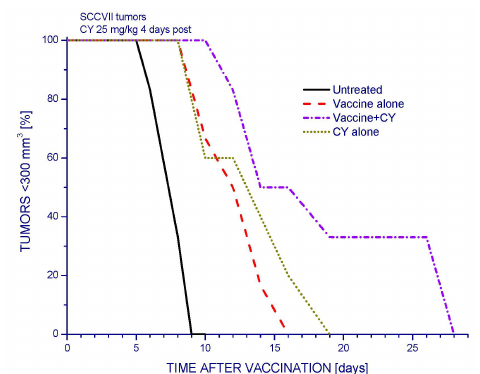
Figure 2. Increased efficacy of PDT vaccine when combined with cyclophosphamide treatment. Mice with SCCVII tumors were treated with PDT vaccine as described for Figure 1. Single injection of cyclophosphamide (25 mg/kg i.p.) was given four days post vaccination. The results are presented as percentages of mice with tumors smaller than 300 mm 3 in function of time after vaccination. Each treatment group consisted of six mice. Statistically significant ( p < 0.05) were the differences between the control untreated group response and all three treatment group responses, between vaccine alone response and vaccine plus cyclophosphamide response, and between vaccine plus cyclophosphamide and cyclophosphamide alone responses.